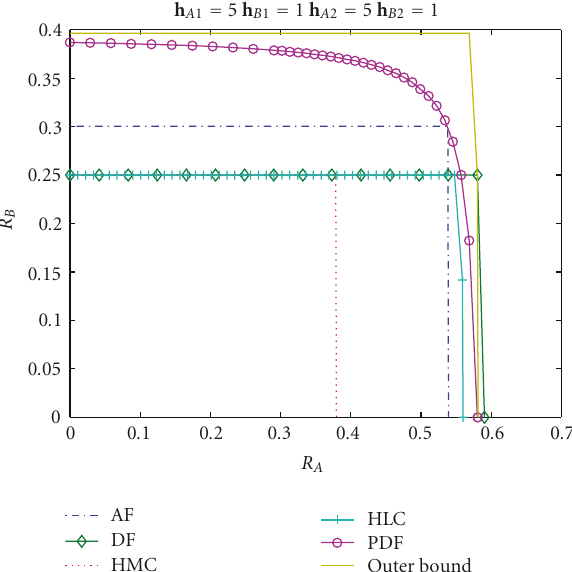
Figure 6: The achievable rate regions when both relays are close to terminal A .